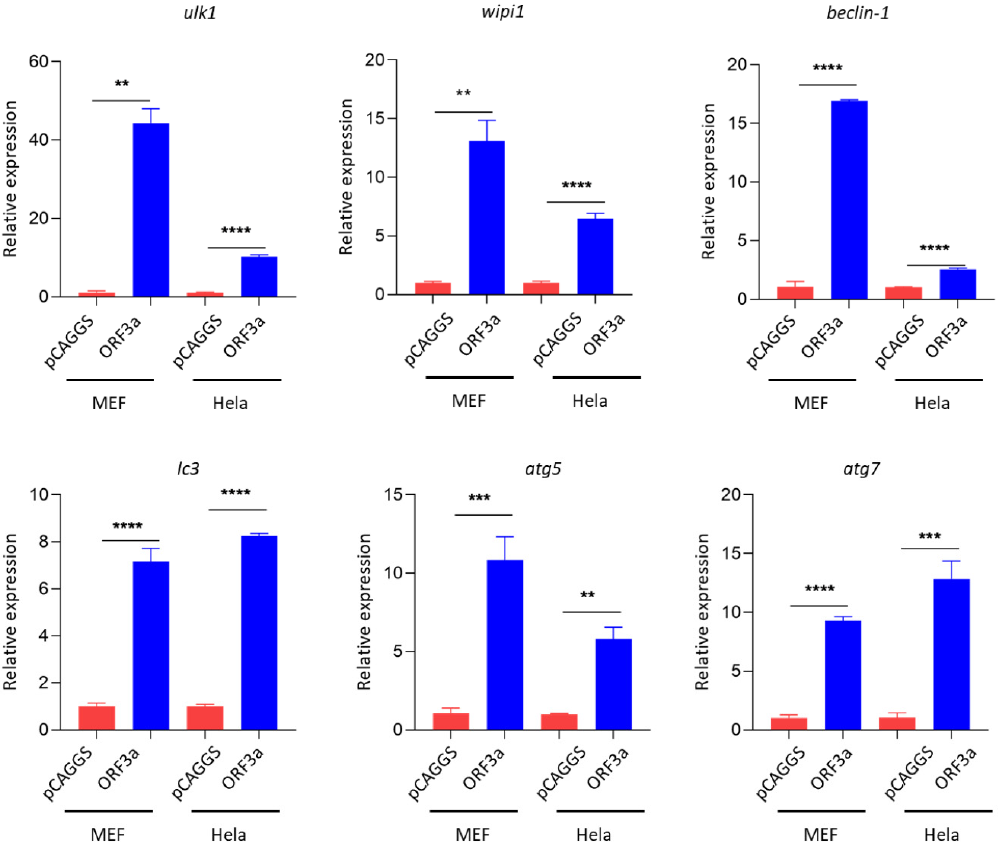
Figure 1. SARS-CoV-2 ORF3a promoted the expression of autophagy-related genes. Hela and MEF cells (1–2 × 10 5 cells) were transfected with HA-Tag-ORF3a (2 μ g) or empty vector (2 μ g) for 24 h. qPCR was performed to detect the expression level of ulk1 , atg13 , beclin-1 , wipi1 , atg5 , atg7 , p62, and lc3 . Data were analyzed by T-tests or T-tests with Welch’s correction. qPCR Data (mean ± SEM) are representative of three independent experiments. ** p ≤ 0.01, *** p ≤ 0.001, **** p ≤